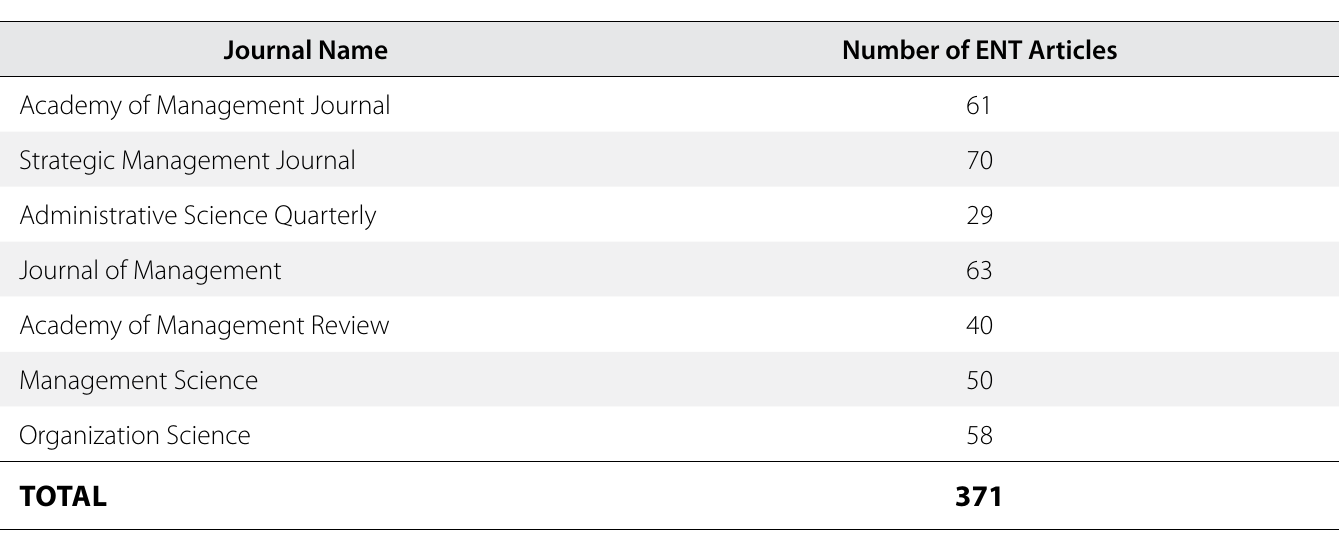
Table 1. Distribution of Entrepreneurship Articles in